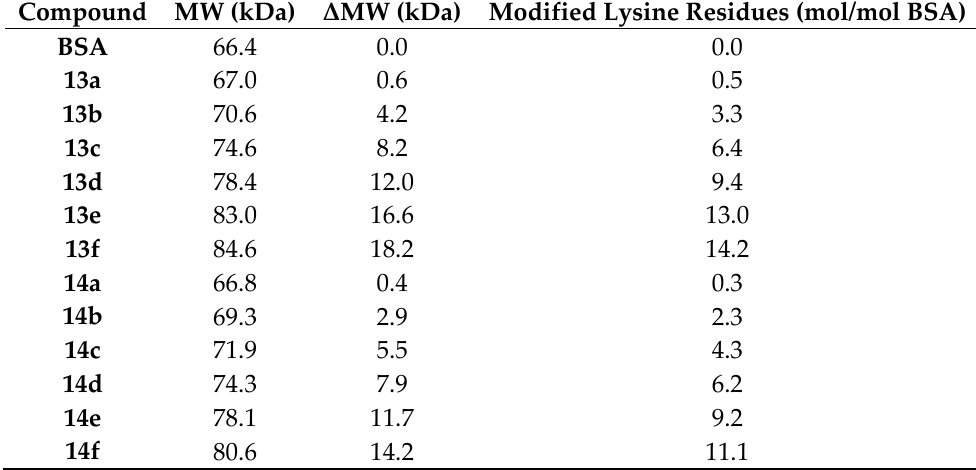
Table 1. Glycosylation densities of neo-glycoproteins 13a – f and 14a – f . The differences in molecular weights ( Δ MW) compared to BSA determined by SDS-PAGE were used to calculate the number of attached 6-biotin LacNAc-LacNAc ( 13a – f ) and 6-biotin LacdiNAc-LacNAc ( 14a – f ). Consequential molecular weights (MW) are given, as